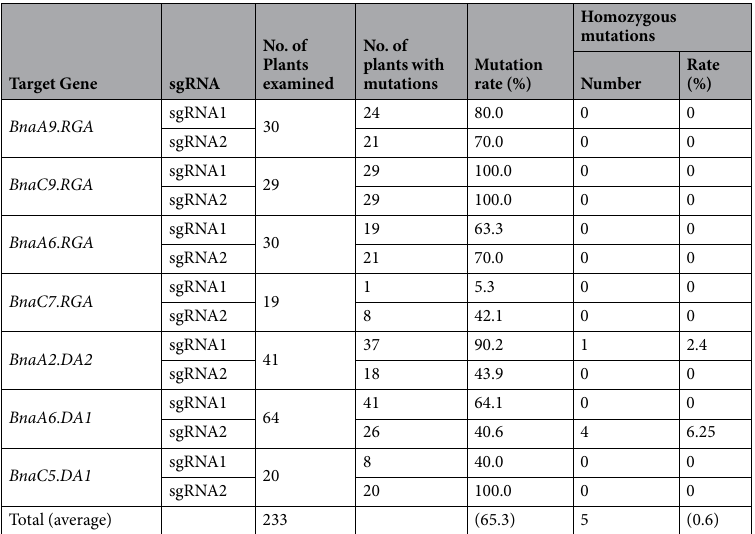
Table 1. Percentage of mutated plants in the T0 generation induced by single-gene targeted sgRNAs.